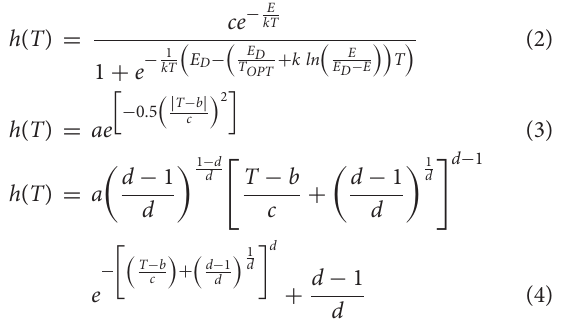
Frontiers in Marine Science |